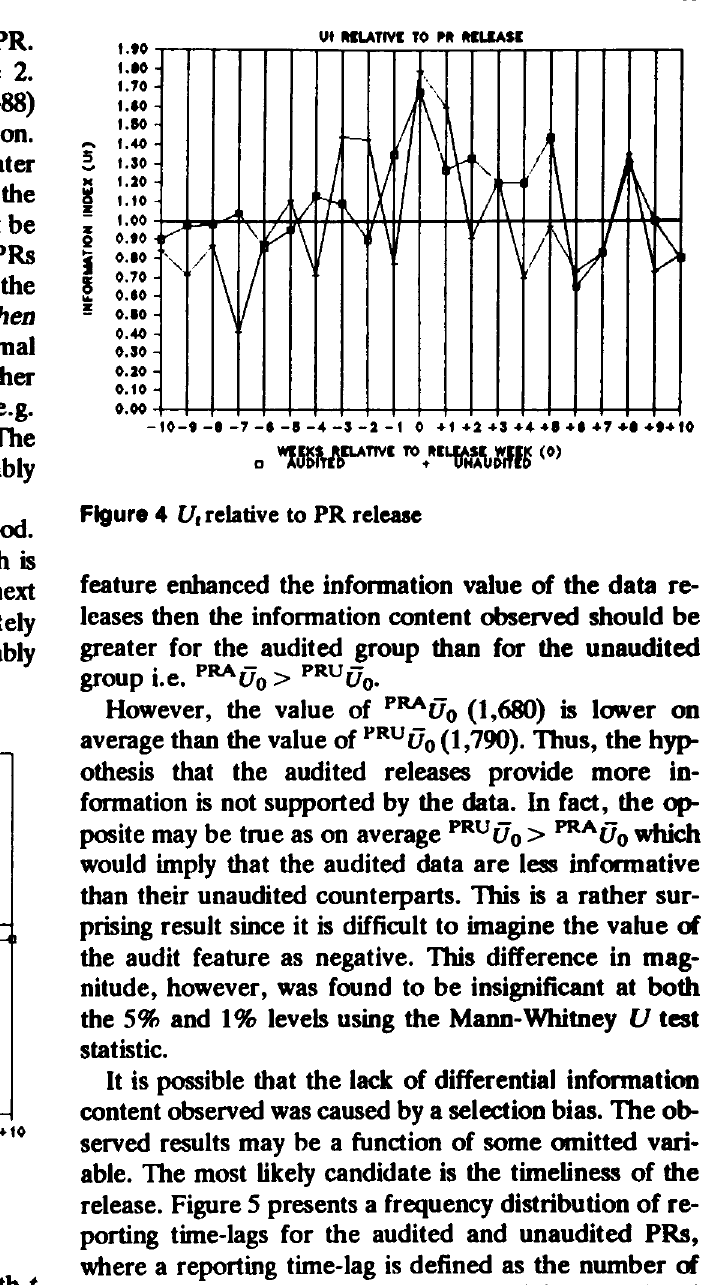
Figure 3 U 1 relative to IR release